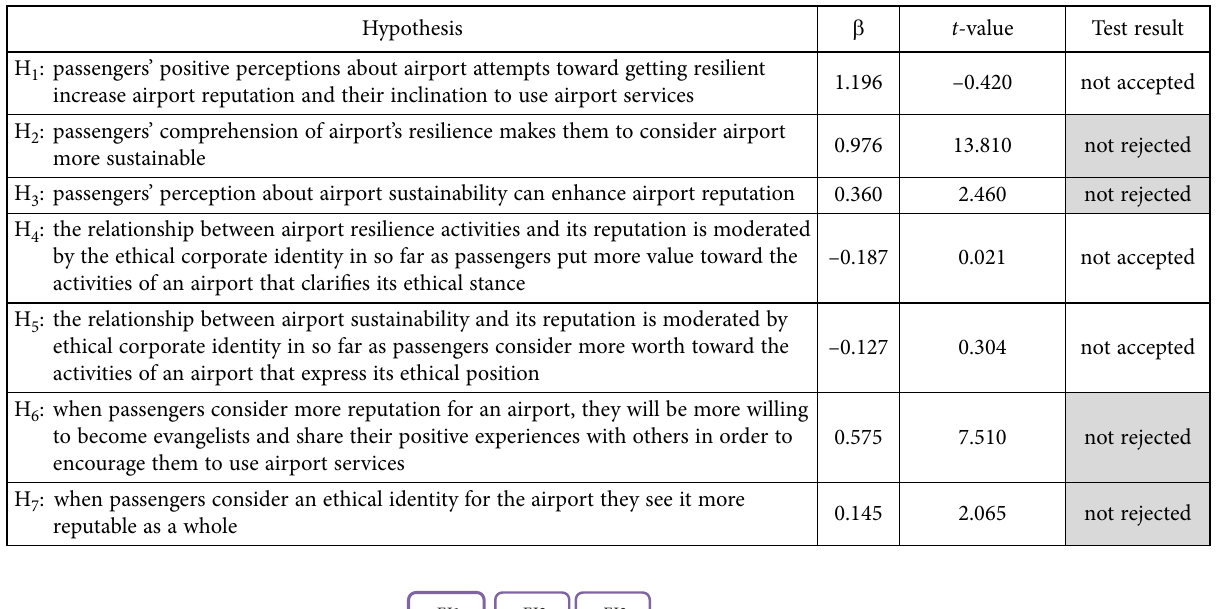
Table 5. Results of hypotheses testing